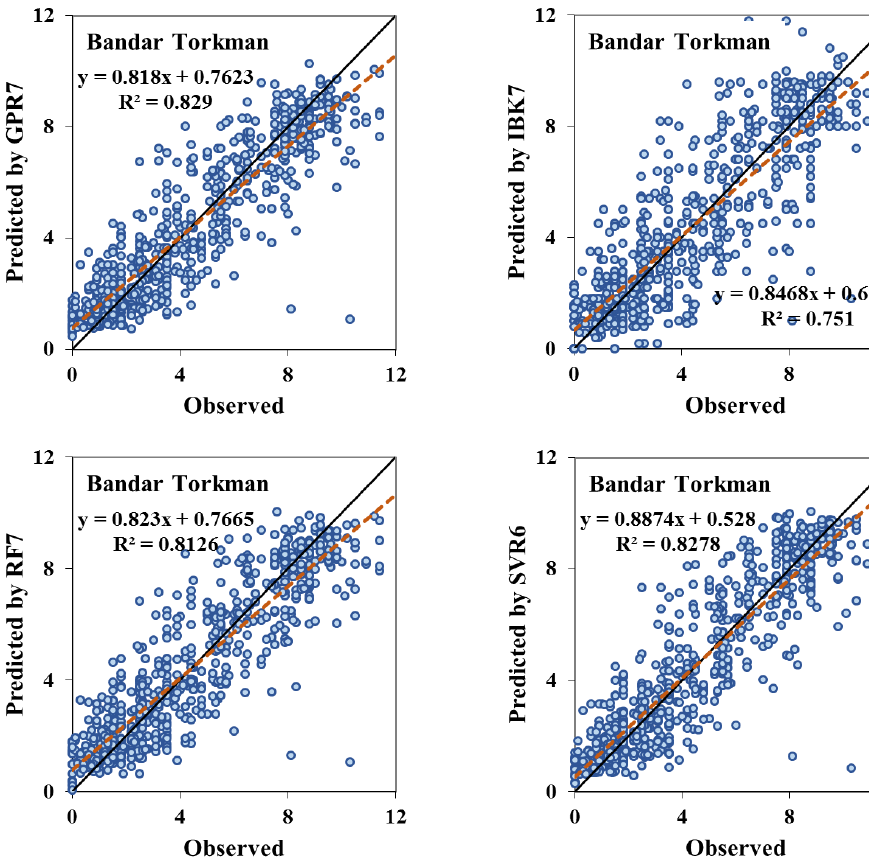
Figure 3. Scatterplots of observed and predicted PE values using the most accurate models.